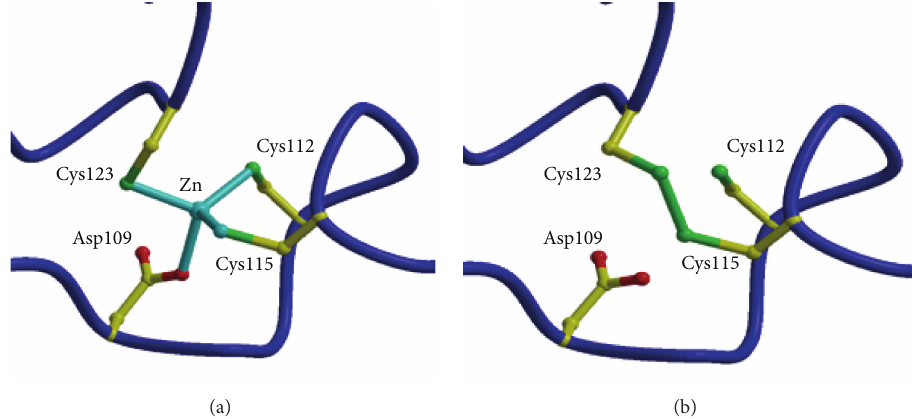
Figure 6: (a) The binding site of the structural zinc ion in the Aeropyrum ADH enzyme. (b) When zinc is not present a disulfide bond forms to stabilise the enzyme at this position in its structure (PDB code 1H2B). The figure was constructed with Bobscript